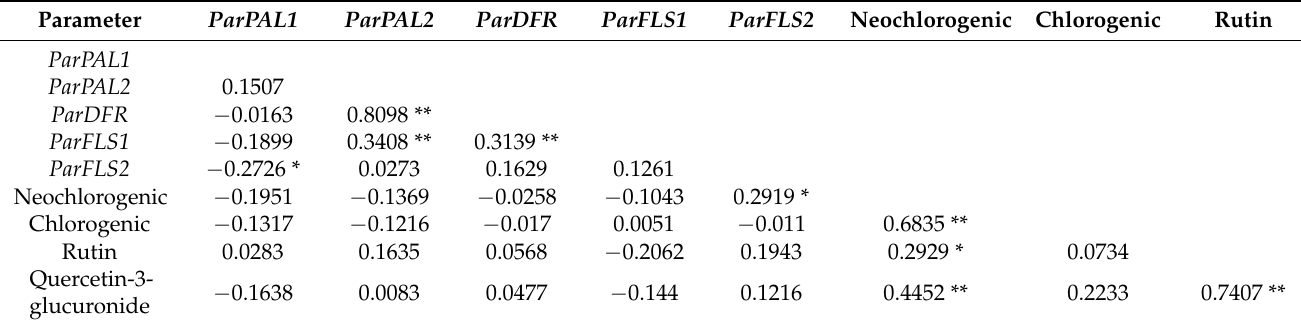
Table 4. Pearson correlation coefficients among compounds and gene expression.